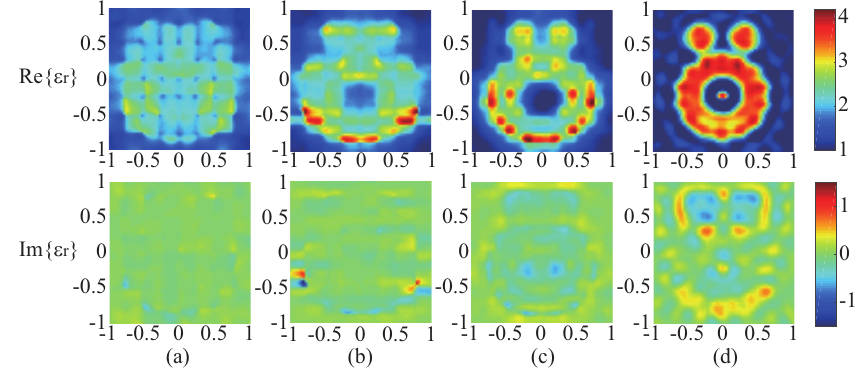
Figure 5. Reconstructed results of ( a ) first round of optimization, ( b ) second round of optimization, ( c ) third round of optimization, and ( d ) fourth round of optimization by WT-TSOM for “Austria” profile with ε r = 4.0. The real ( first row ) and imaginary ( second row ) of the reconstructed results. The 1st, 2nd, 3rd, and 4th rounds of optimization correspond to β being 6, 3, 0.5, and 0, coupled with M w being 64, 128, 256, and 1024,